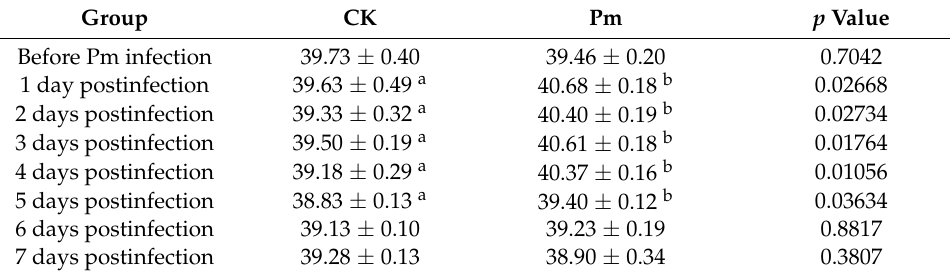
Table 1. Body temperature of goats recorded for 7 days after Pm infection. Group CK Pm p Value Before Pm infection